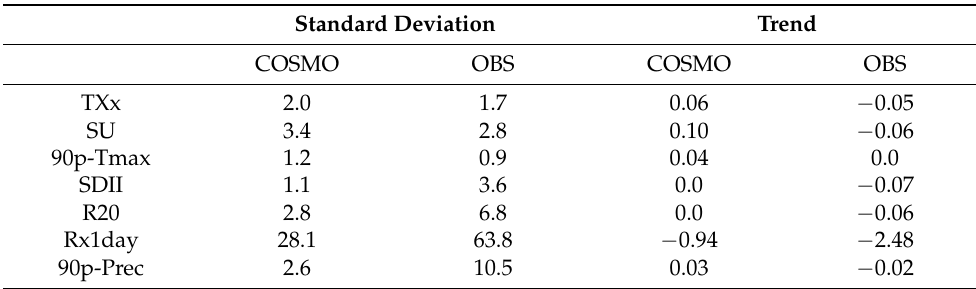
Table 4. Standard deviation and trend of the EWI considered over the historical period 1981–2010, for model and observational